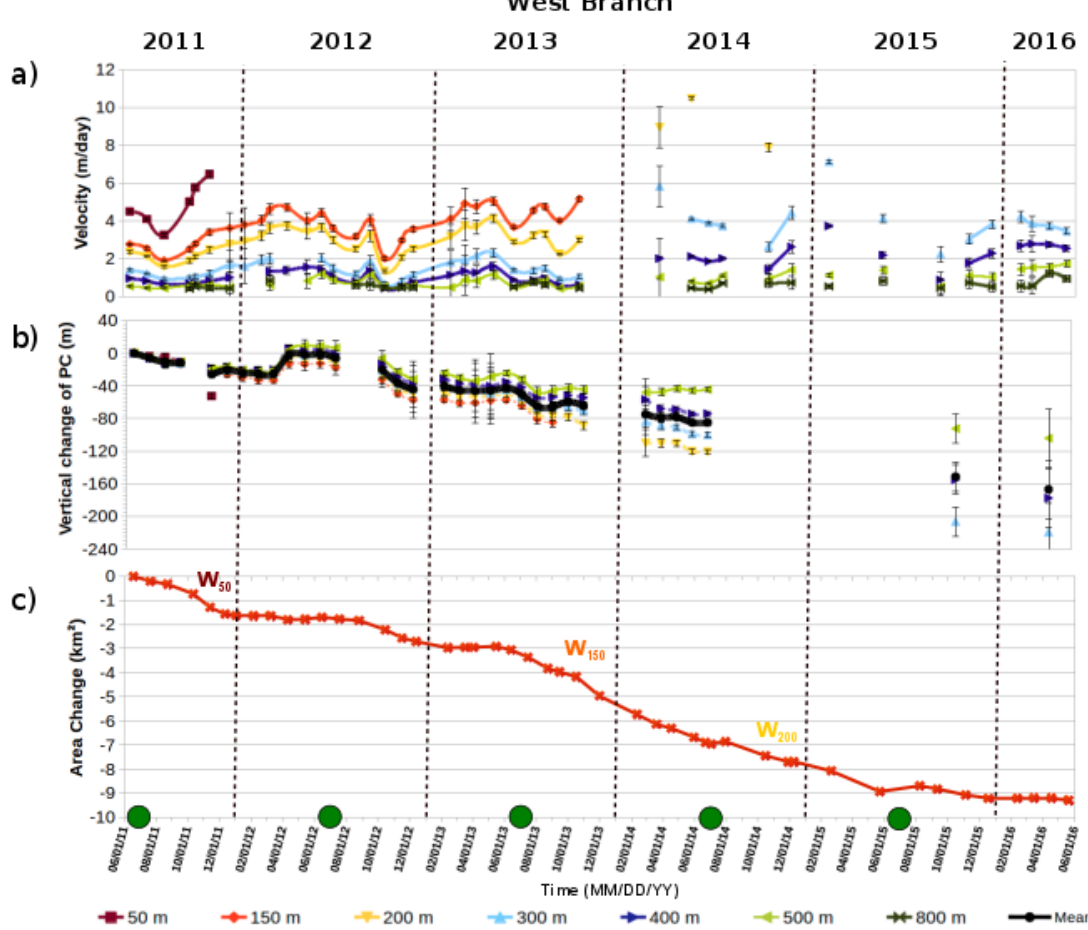
Figure 3. Temporal variation of ( a ) glacier surface velocities; ( b ) vertical change of the scattering phase center in regard to 06/18/2011; ( c ) area change since 06/18/2011, observed at different elevations (locations indicated in Figure 1) on the west branch of Columbia Glacier, Alaska. The glacier at elevation points W 50 , W 150 , W 200 calved off at the respective times, as indicated in panel ( c ). The green circles at the bottom axis indicate the time when the PC depicts actual surface